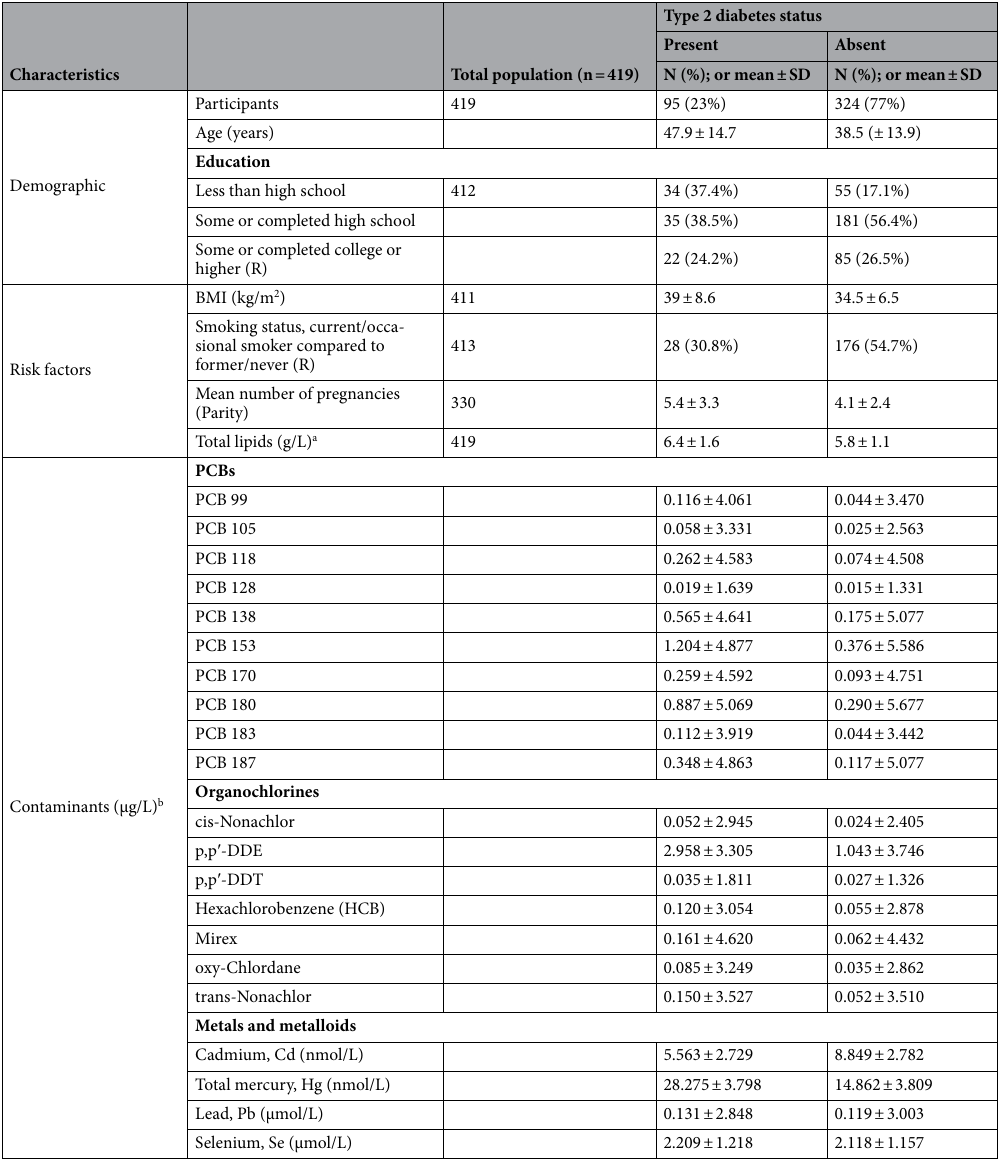
Table 1. Female characteristics stratified by type 2 diabetes mellitus status: results from the Nituuchischaayihtitaau Aschii —Multi-Community Environment-and-Health Study (2005–2009). Missing values among adult females: Education (n = 7, 1.7%); BMI (n = 8, 1.9%); Smoking status (n = 6, 1.4%). N, frequency value; %, percentage; BMI, Body mass index; R, reference category; PCB, Polychlorinated biphenyl congeners; p,p ′ - DDT, Dichlorodiphenyltrichloroethane; p,p ′ - DDT, Dichlorodiphenyldichloroethylene. Part of this Table is reproduced from Zuk et al. 33 . a Lipid concentrations were determined using methods described by Rylander et al. 2012. b Presented are geometric mean ± standard deviation